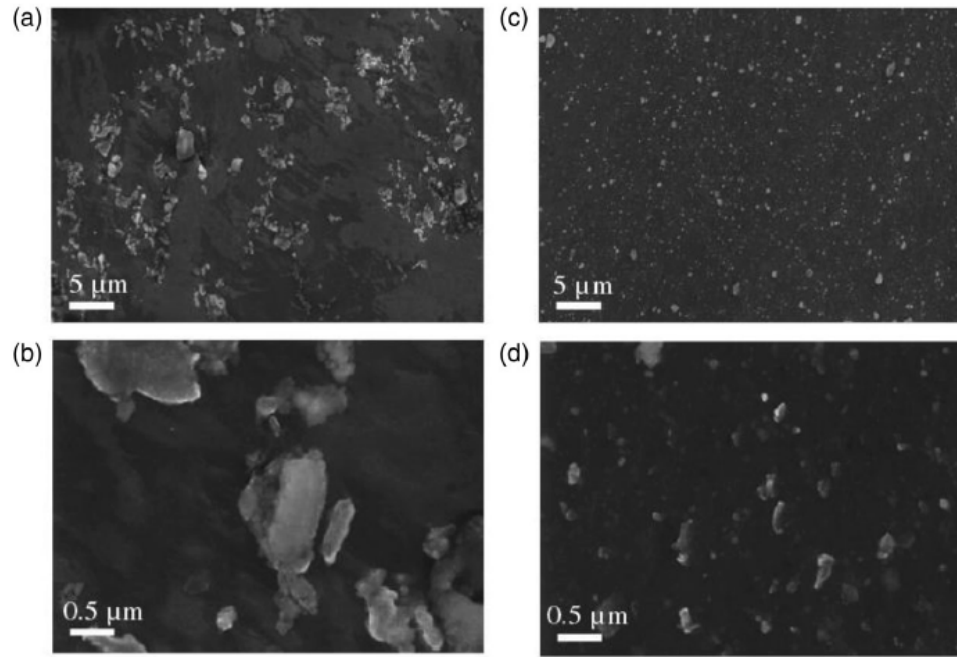
Figure 10. ( a , b ) SEM micrograph of the as-cast ultrasonic processed plate of the GNPs incorporated in the Mg matrix and ( c , d ) the ultrasonic processed and solid state stirred sample, at low and high magnifications [61] (Copyright Elsevier, 2012, Scripta Materialia).